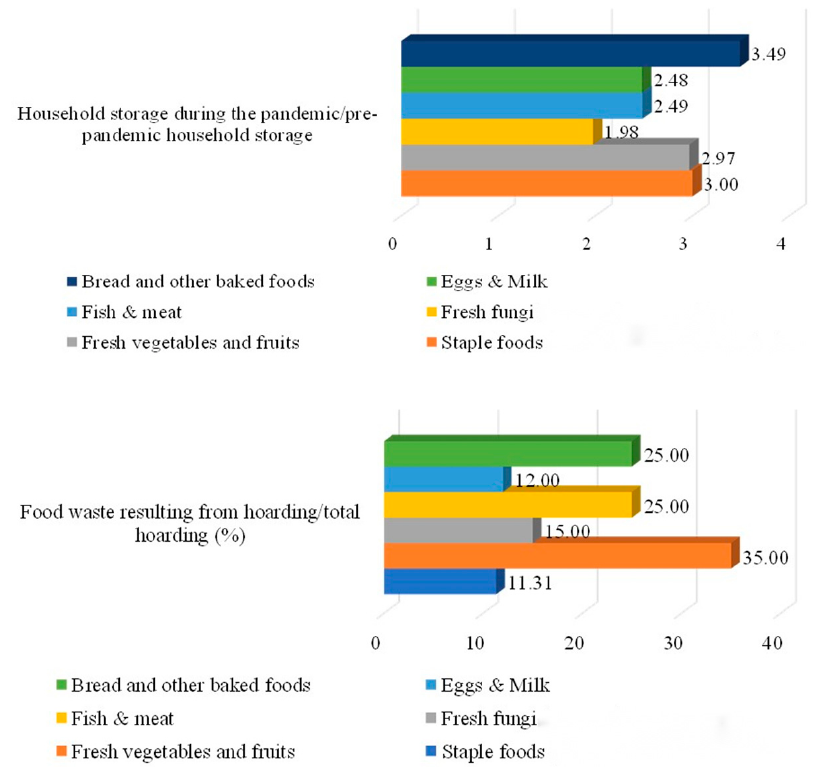
Figure 4. The structure of food hoarding and food waste.